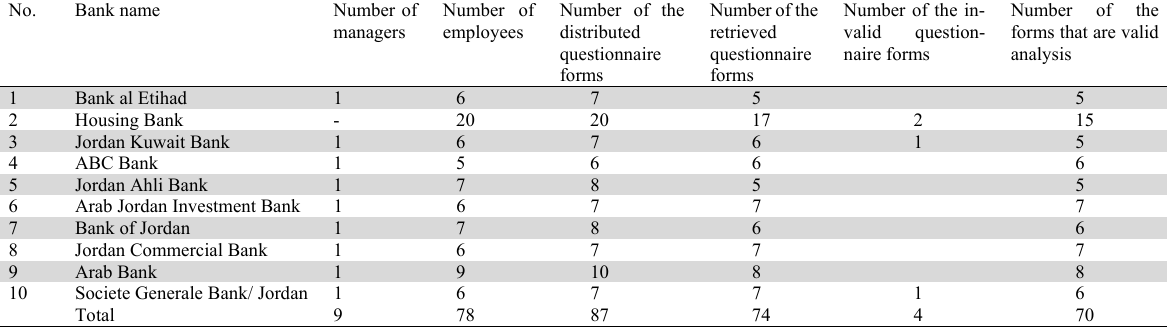
Information about the size of the sample No.